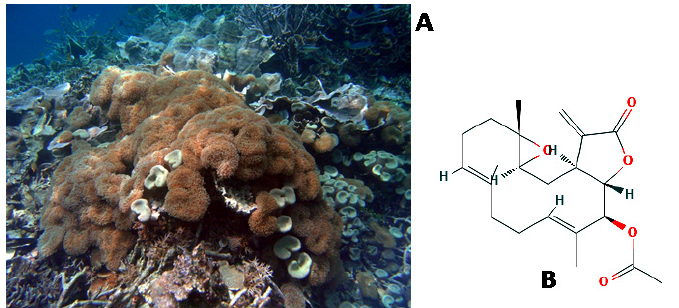
Figure 10. ( A ) A specimen of Sarcophyton crassocaule soft coral © Leen Van Ofwegen (CC BY-NC-SA 4.0); https: // www.marinespecies.org / ( B ) 2D structure of 13-acetoxysarcocrassolide; https: // pubchem. ncbi.nlm.nih.gov / compound / 21775908.